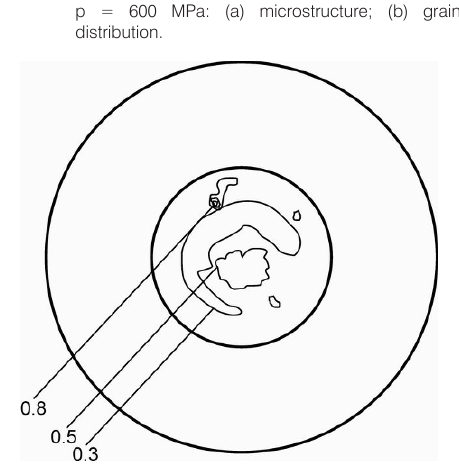
Figure 2. Pole figure {220} of CdTe ceramics after compression at T = 25ºC, p = 600